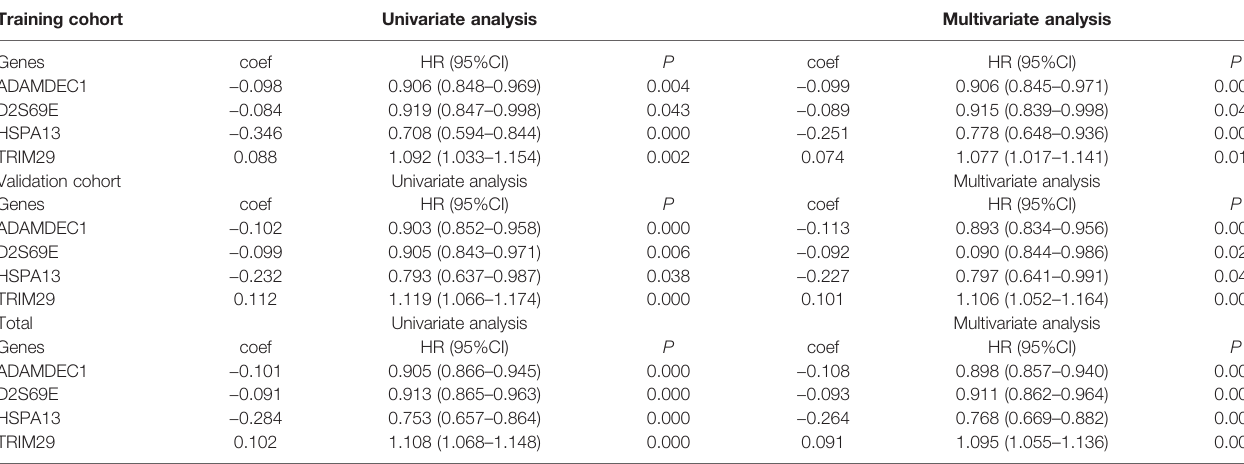
TABLE 2 | Univariate and multivariate analysis of prognosis genes for TCGA